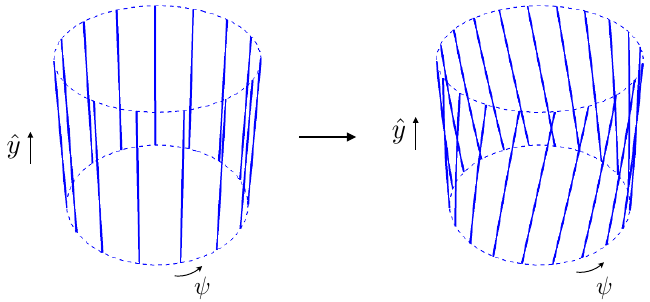
Figure 1 . On the left, a symmetric con(cid:12)guration of NS5 branes on their Coulomb branch. Tilting the branes along the (^ y; ) torus, with a monodromy that links the various strands together, and adding momentum to keep the branes pu(cid:11)ed up, gives an NS5-P supertube. In worldsheet string theory, the tilting corresponds to a rotation of the null current being gauged inside SL(2 ; R ) (cid:2) SU(2) (cid:2) R 1 ; 1